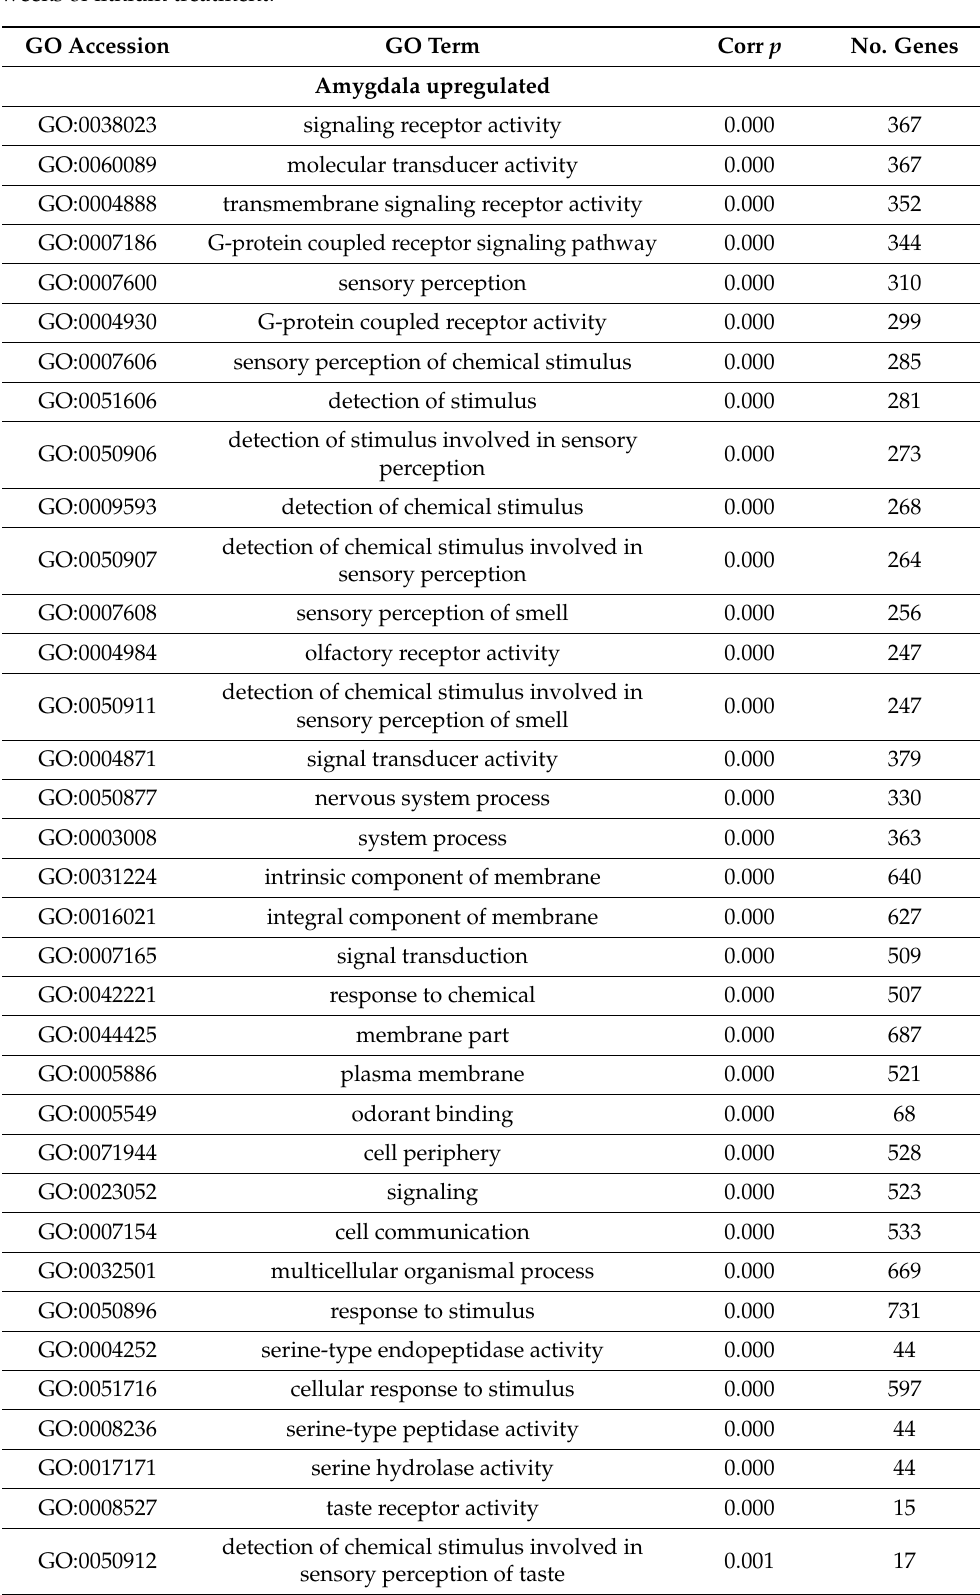
Table 3. Differentially expressed genes enriched in GO terms in amphetamine-exposed rats after two weeks of lithium